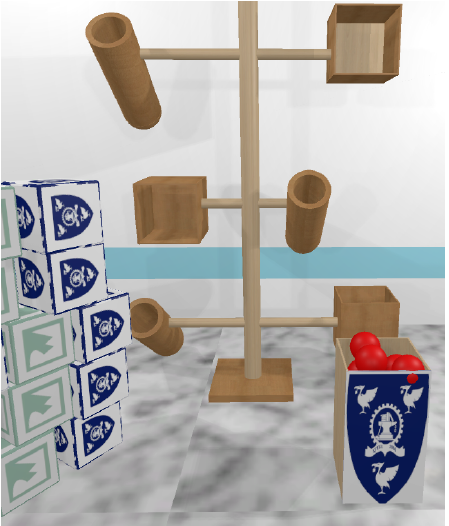
Figure 5. VR environment layout: The environment consist of a wooden stand, balls and cubes that participants relocate into the respective